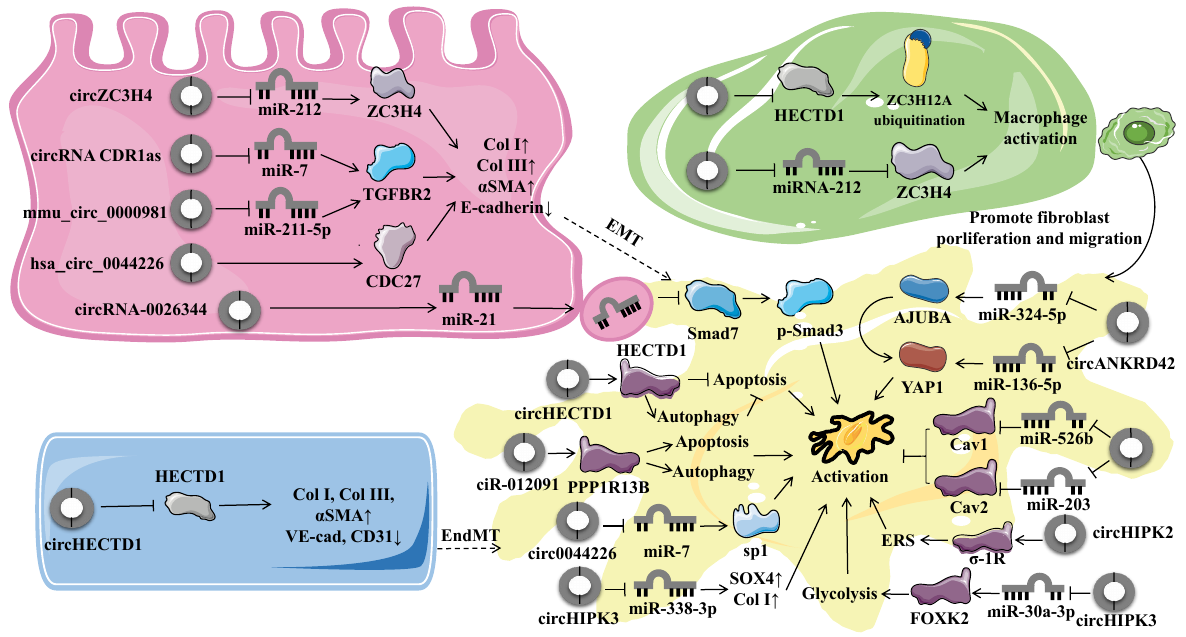
Figure 5. circRNAs in pulmonary fibrosis and their influence on biological processes. CircRNA dys- regulation intrigues a complex interplay of signaling pathways in endothelial-to-mesenchymal transi- tion, epithelial-to-mesenchymal transition, macrophage activation, and fibroblast-to-myofibroblast